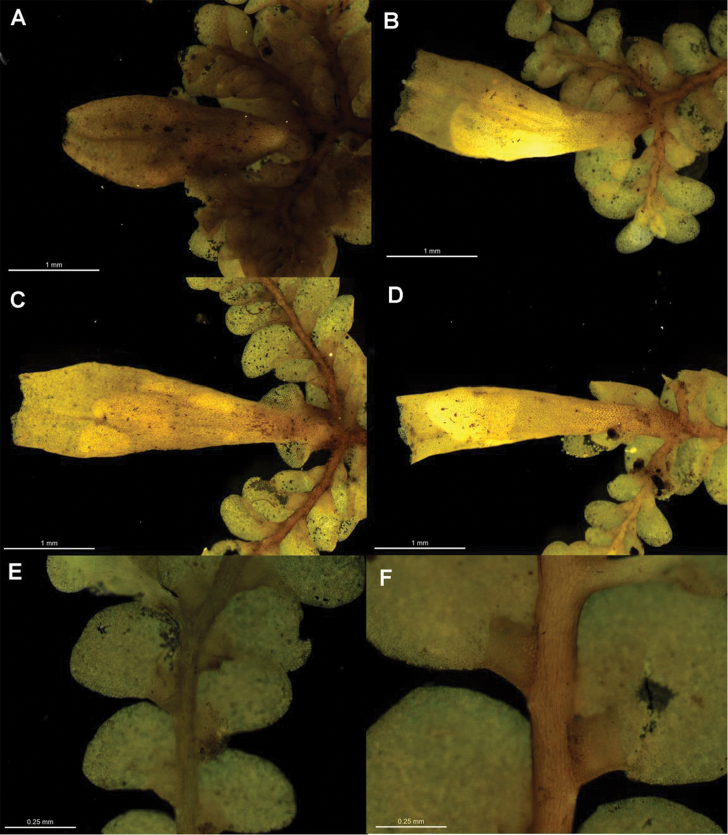
Radula strangulata Pictures 2. A–D Perianths showing variation in size and shape associated with development A youngest D oldest and mature E–F ventral view of lobules on primary shoots illustrating more inter-individual variation in size and shape of lobules and leaf-lobes E NSW896405 F NSW895357. Others NSW970841.